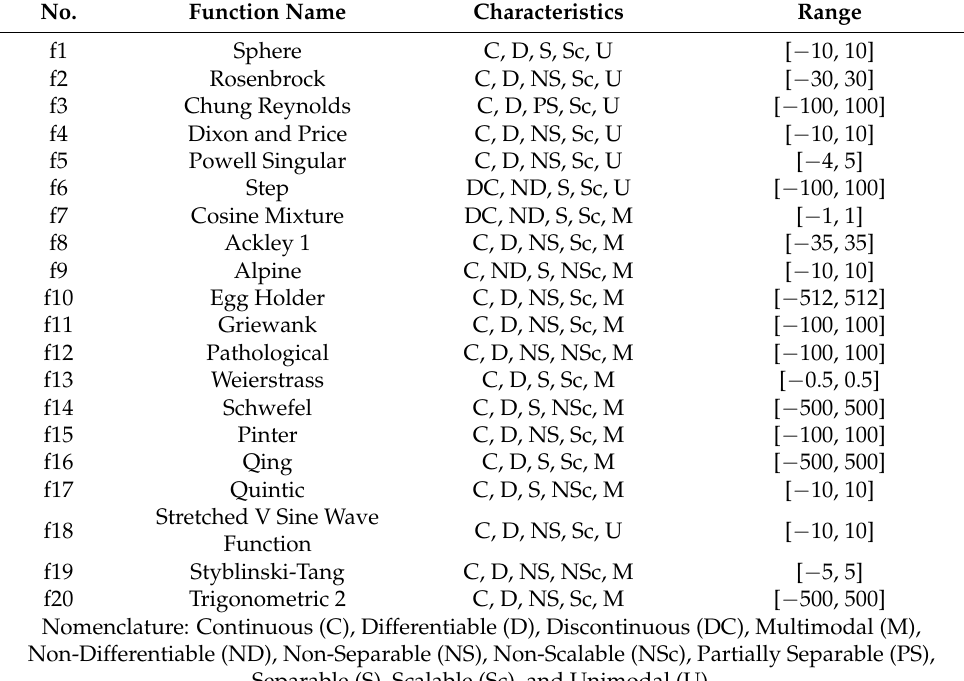
Table 2. Benchmark functions (Unconstrained).